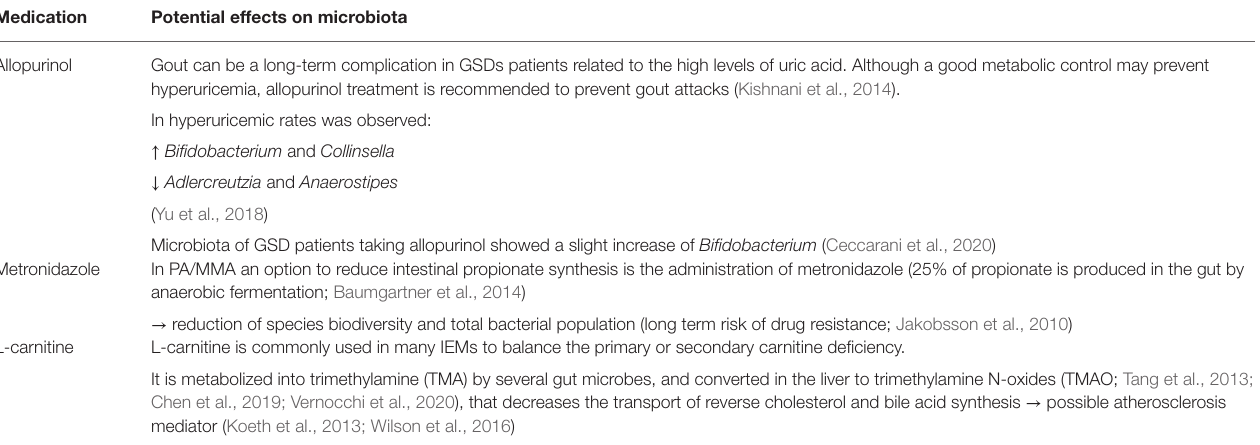
TABLE 2 | Potential effects of use of specific medications on the gut microbiota in